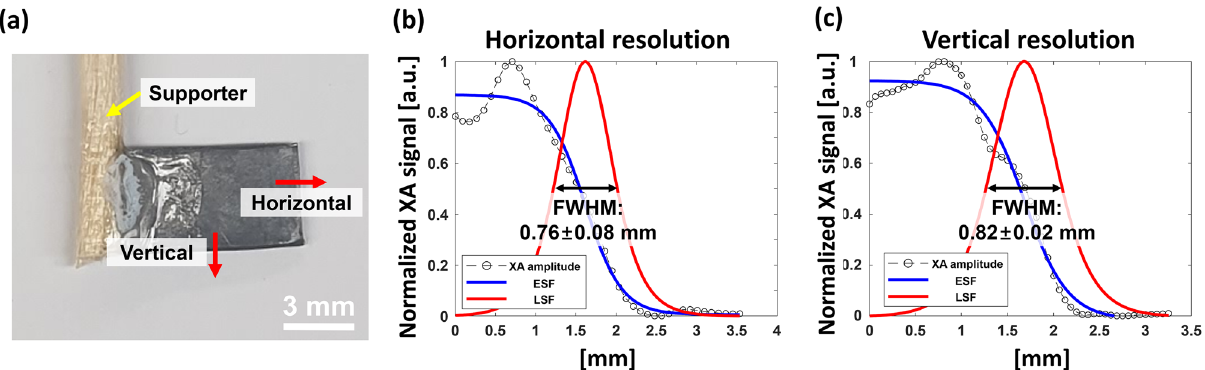
Figure 4. ( a ) Photograph of a rectangular lead target. ESF and LSF fittings from experimental XA data across ( b ) the horizontal and ( c ) the vertical directions; XA, X-ray induced acoustic; FWHM, full width at half maximum; ESF, edge spread function; and LSF, line spread